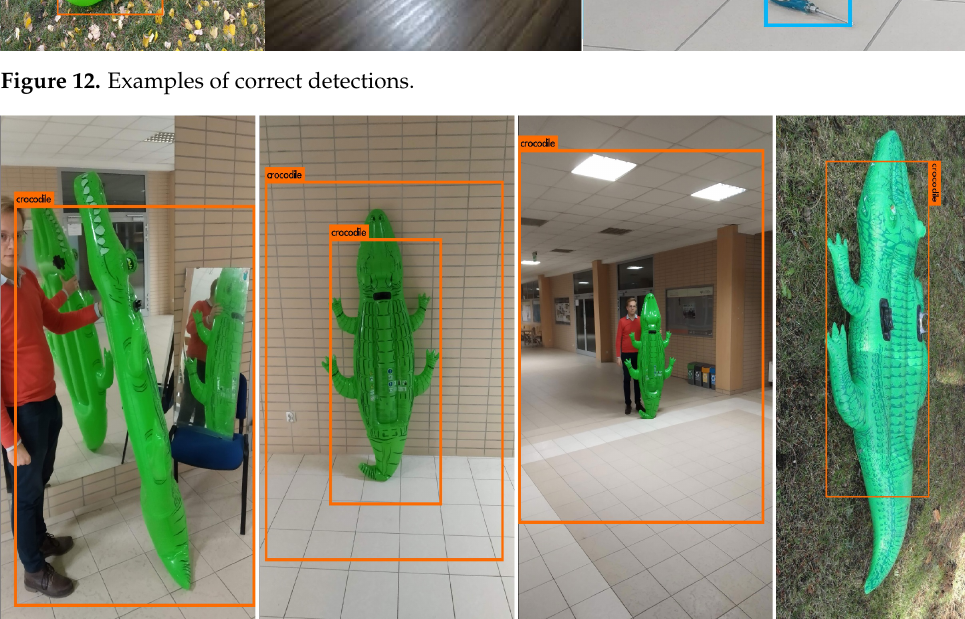
Figure 13. Examples of incorrect